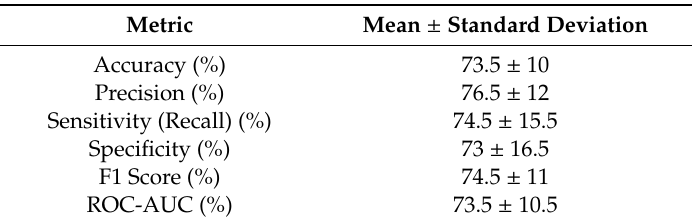
Table 2. Mean and standard deviation of classification metrics.